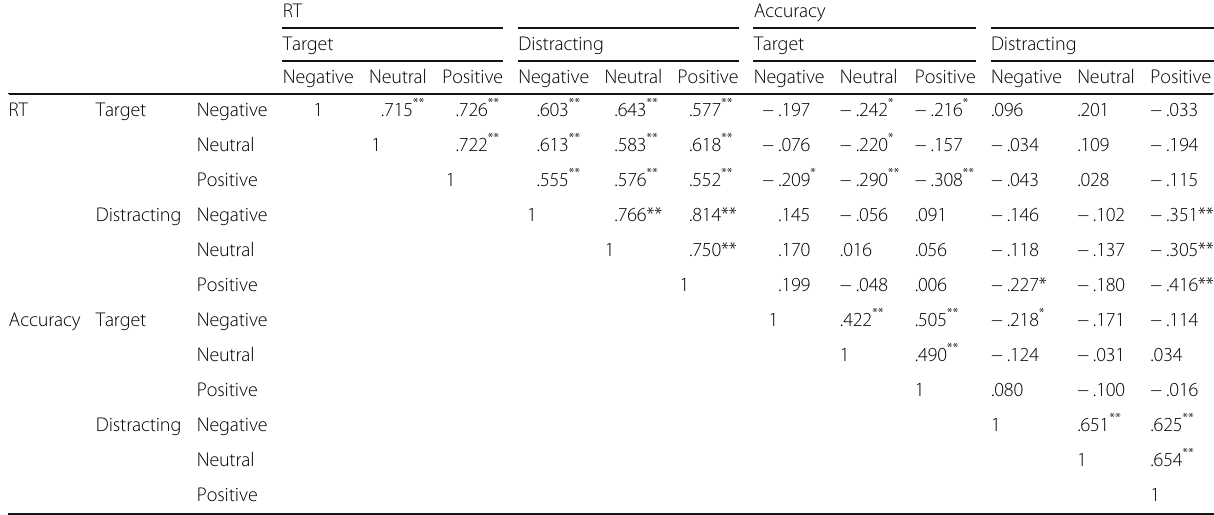
Table 3 Pearson coefficients across RT, accuracy, emotional valence, and condition (target and